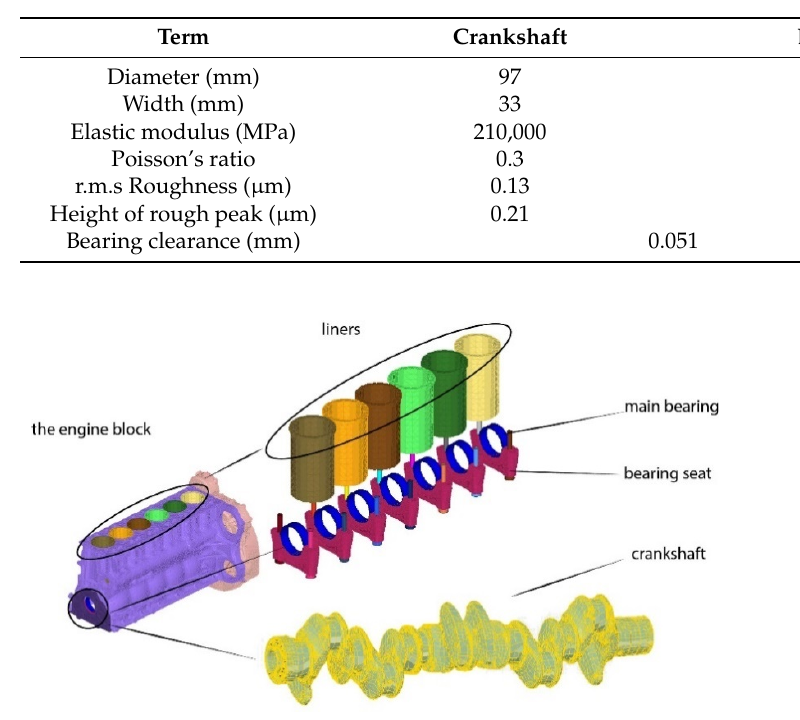
Table 7. Geometric character and material properties.